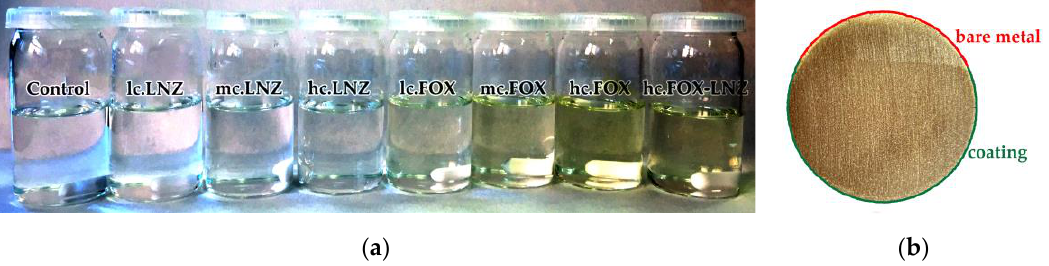
Figure 1. ( a ) Production batch of the sol – gels of all the formulations analyzed (antibiotic-free coating: Control; LNZ-loaded coatings: lc.LNZ, mc.LNZ, and hc.LNZ; FOX-loaded coatings: lc.FOX, mc.FOX, and hc.FOX; and coating loaded with both antibiotics: hc.FOX-LNZ). ( b ) Example of a coating deposited on a titanium disc produced by powder metallurgical route (part of the metal area was left uncoated for exemplification and visual support).